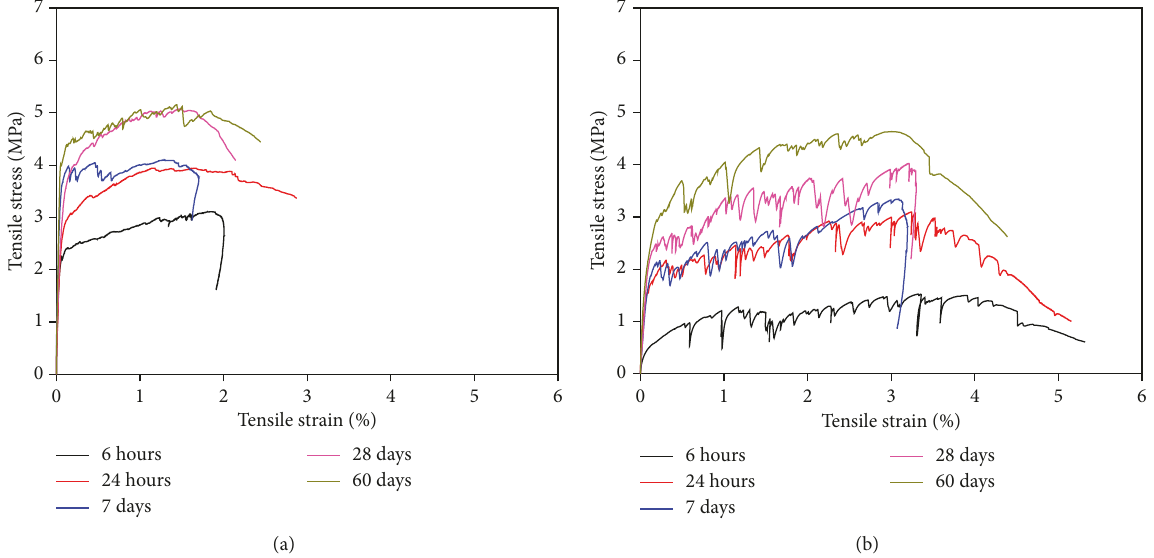
Figure 13: Uniaxial tensile stress-strain curves of HES-ECCs with different curing ages: (a) ECC2; (b)